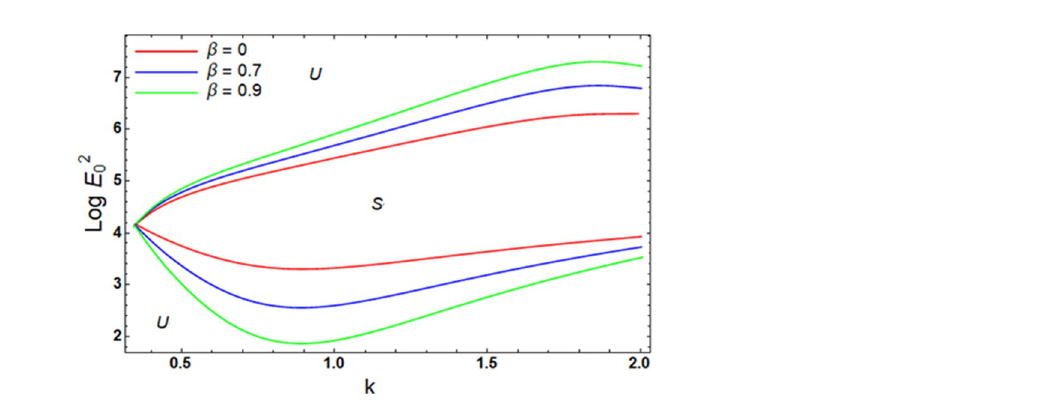
Figure 9. Exhibits the alteration in β of inequality (62) and